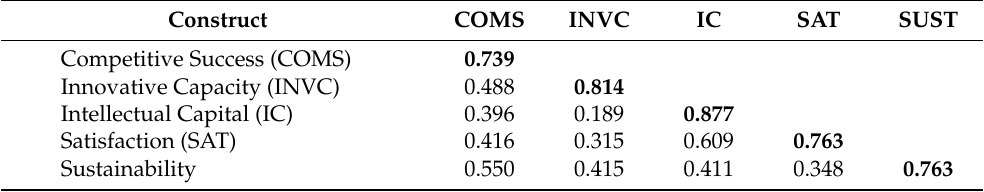
Table 3. Discriminant validity Fornell and Lacker.